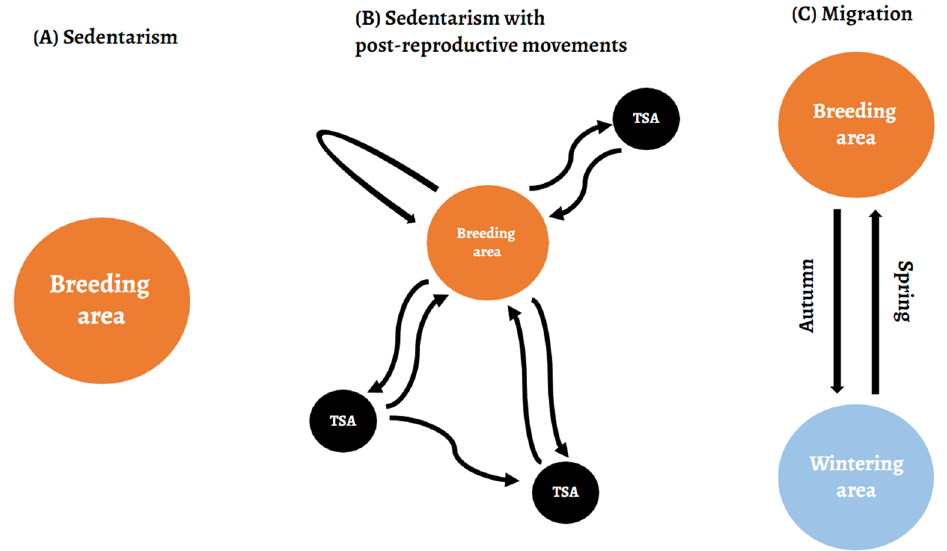
Figure 2. Scheme of the strategies followed by the red kites. ( A ) Sedentarism: routine day-to-day movements restricted to a circumscribed home range; ( B ) Sedentarism with post-reproductive movements: a combination of wandering movements and stopping in temporary settlement areas (TSA) after breeding season, without marked seasonality or direction, involving a return journey after that in time to next breeding season; ( C ) Migration: regular and fixed movements between two areas twice a year (spring and autumn).